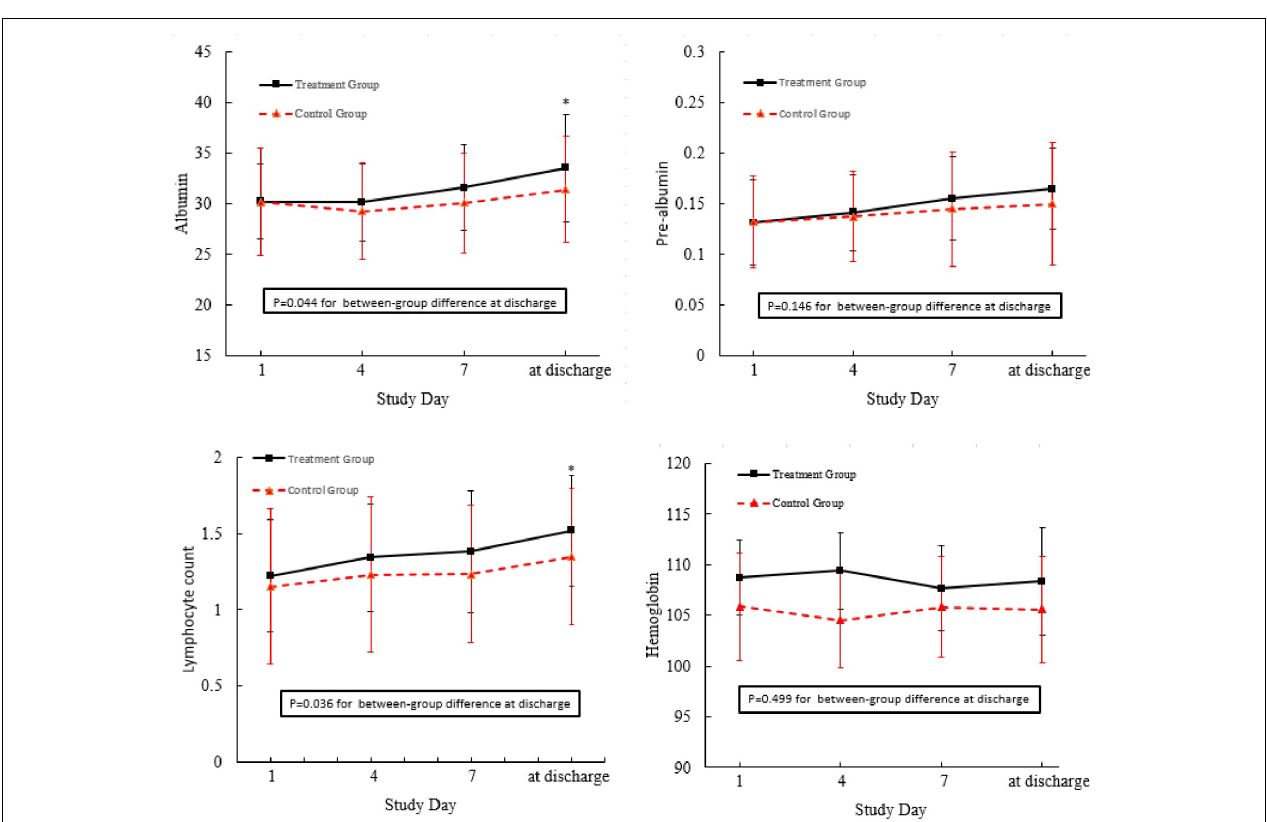
FIGURE 3 | Nutrient status of the patients admitted to this trial. ∗ p < 0.05 compared with control group.